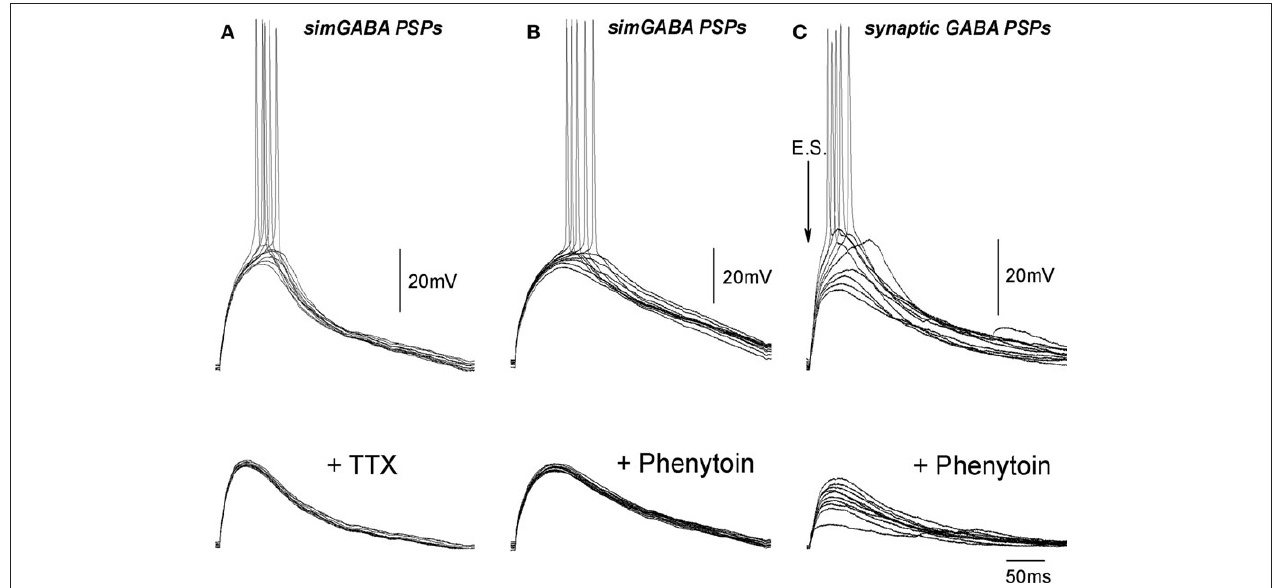
Figure 7 | Na + channel blockers inhibit subthreshold voltage-gated conductance and the action potentials evoked by simulated and synaptic gABA-PSPs. (A, B) Example traces of simGABA-PSPs evoked by injection of GABA-PSC waveform in control conditions (upper traces) and in the presence of 1 μM TTX (A) and 200 μM phenytoin (B) (bottom traces). (C) Synaptic GABA-PSPs in control conditions (upper traces) and in the presence of 100 μM phenytoin (bottom